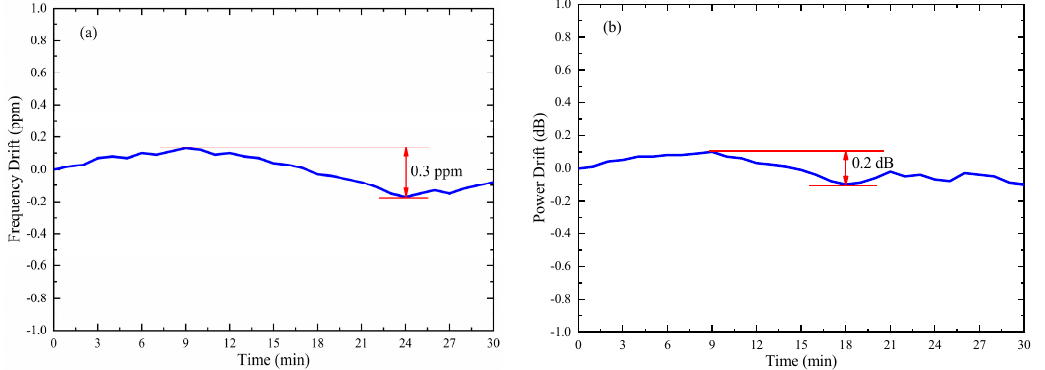
Figure 8. ( a ) The frequency drift of the coupled dual-loop SBS-based TOEO at 10 GHz; ( b ) the power drift of the coupled dual-loop SBS-based TOEO at 10 GHz.